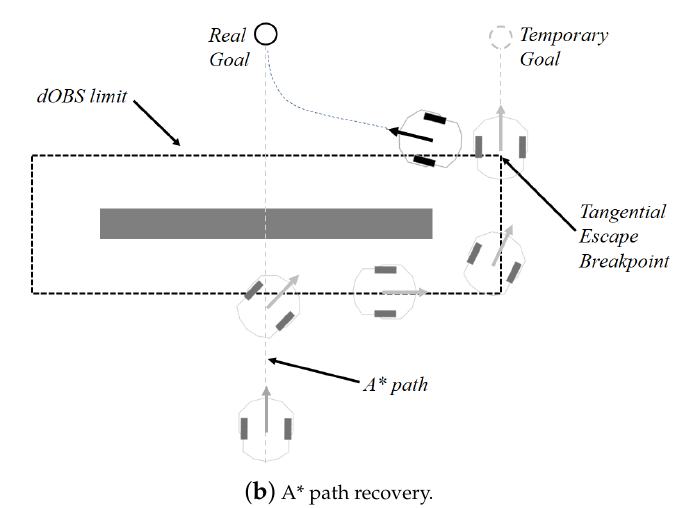
Figure 4. Tangential escape and recovery point